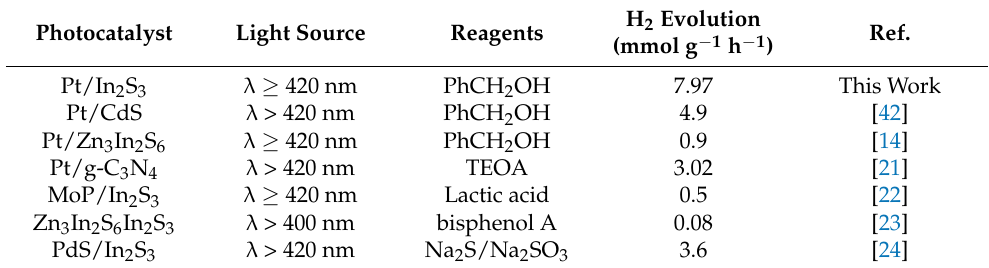
Table 1. Comparison of photocatalytic performance over different photocatalysts for photocatalytic H 2